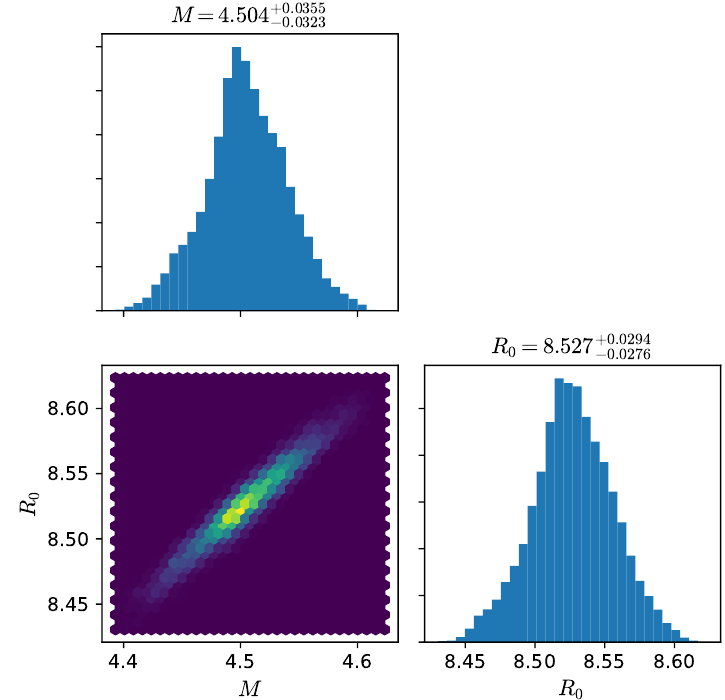
Figure 2. The posterior distribution of β PPN and γ PPN .